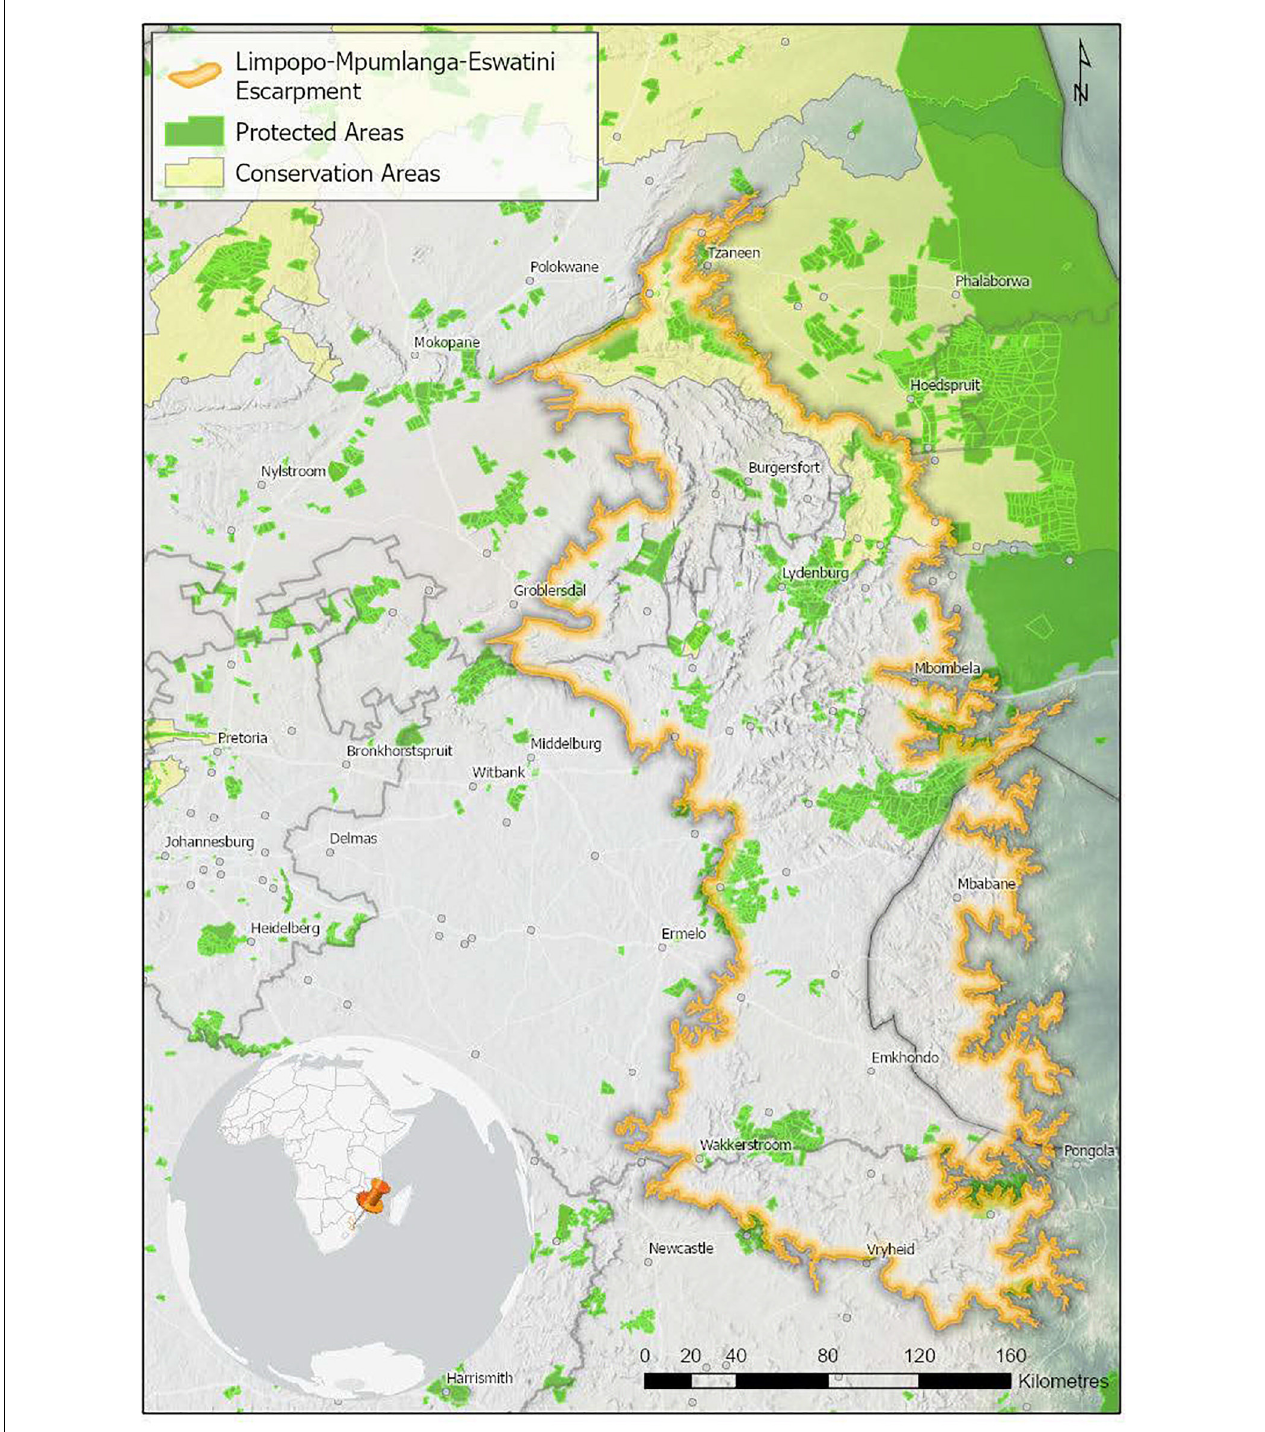
FIGURE 7 | Protected and conservation areas in the Limpopo–Mpumalanga–Eswatini Escarpment (LMME) in 2020. Protected areas are recognized in terms of the National Environmental Management Protected Areas Act (Act No. 57 of 2003), and restrict certain kinds of developments that may have a negative impact. Conservation Areas are more loosely defined, and offer little protection against a change in land use. Data from Department of Forestry, Fisheries and the Environment [DFFE] (2021a,b).